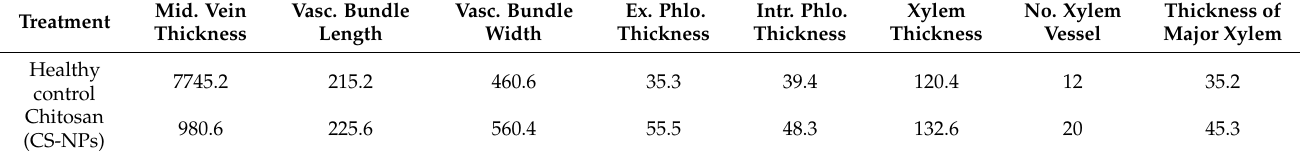
Table 3. Vascular bundle and xylem ( µ m) properties of potato leaves treated with chitosan (CS-NPs).